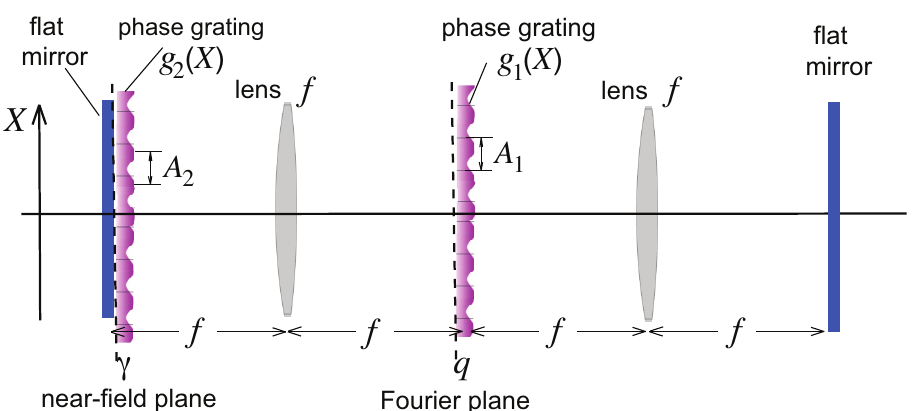
Figure 8: Schematic of a self-imaging optical resonator with flat end mirrors and with two phase gratings placed at the near-field (flat end mirror at the left side) and Fourier (far-field) planes. The spatial periods of the two gratings are A A , respectively. The irrational α is defined in terms of physical parameters by 2 α = λ f / ( A ) , where f is the focal length and λ is the light A 1 2